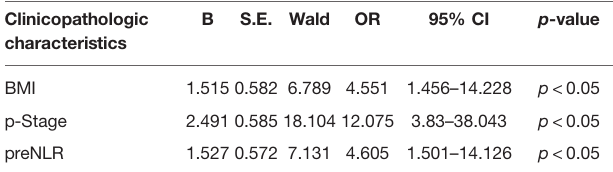
Table 2 . We next analyzed the clinicopathologic characteristics